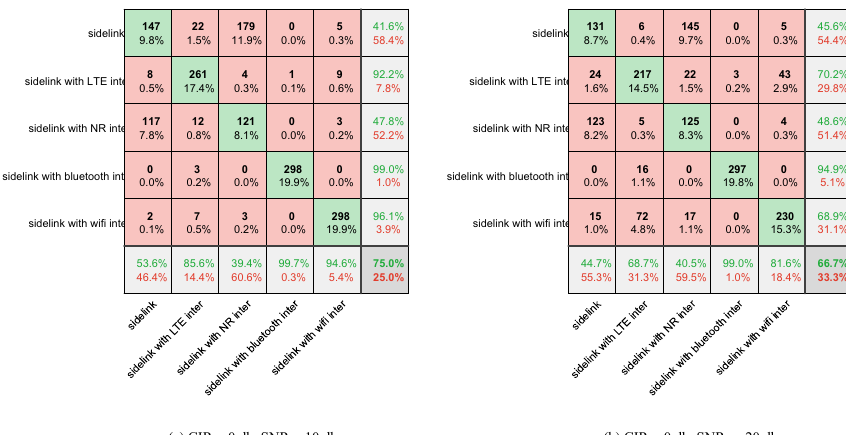
Fig. 11 Confusion matrix of the network output with CIR